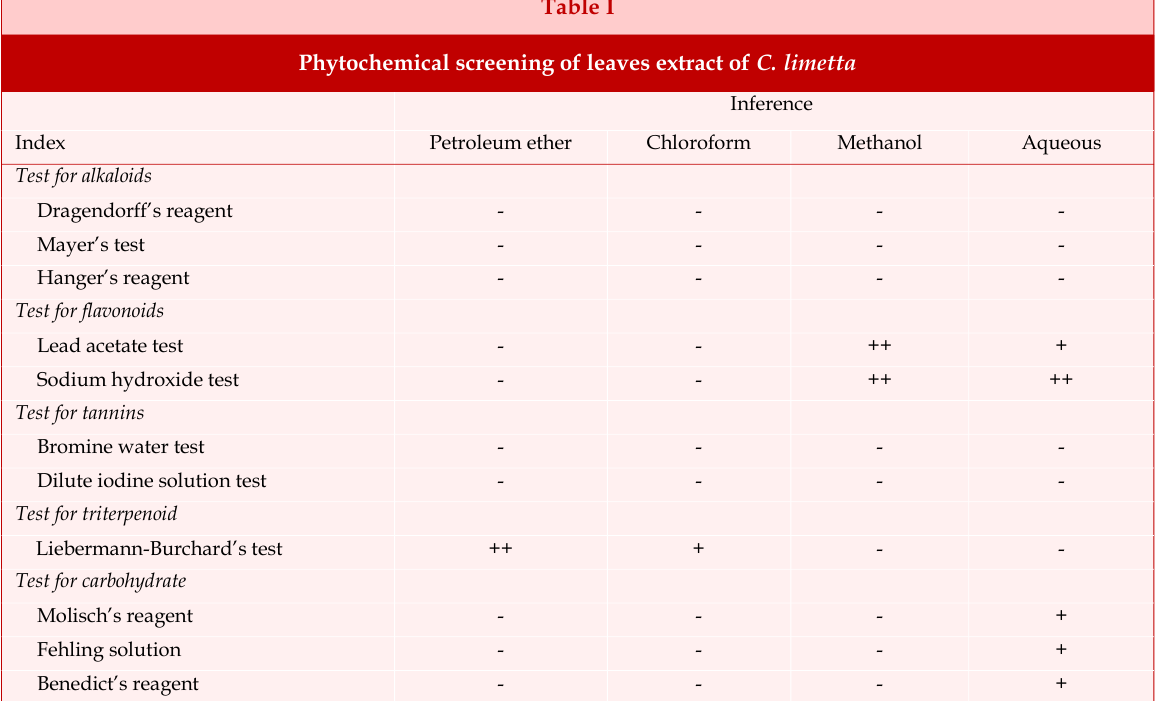
Phytochemical screening of leaves extract of C.